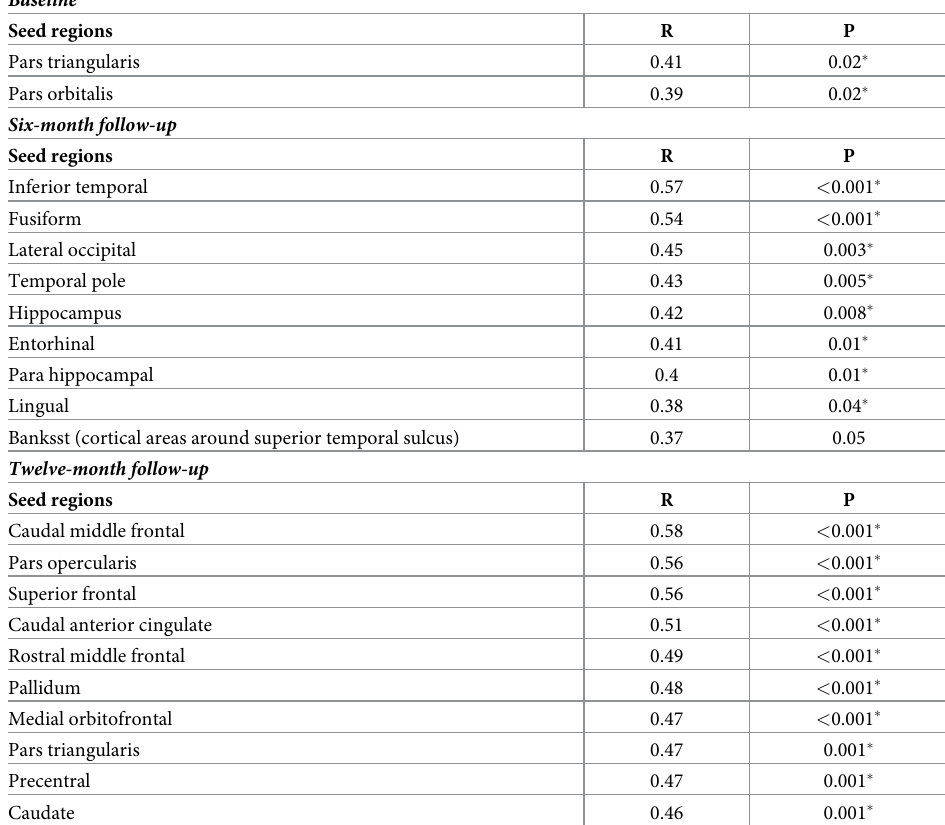
Table 2. Seed regions identified by NDM at baseline (atrophy measured at baseline compared to controls), at six- month follow-up (atrophy measured at six-month follow-up compared to the baseline) and at twelve-month fol- low-up (atrophy measured at twelve- month follow-up compared to the six-month follow-up). R is Pearson’s cor- relation. p values are family-wise error (FWE) corrected). The symbol � denotes significant p